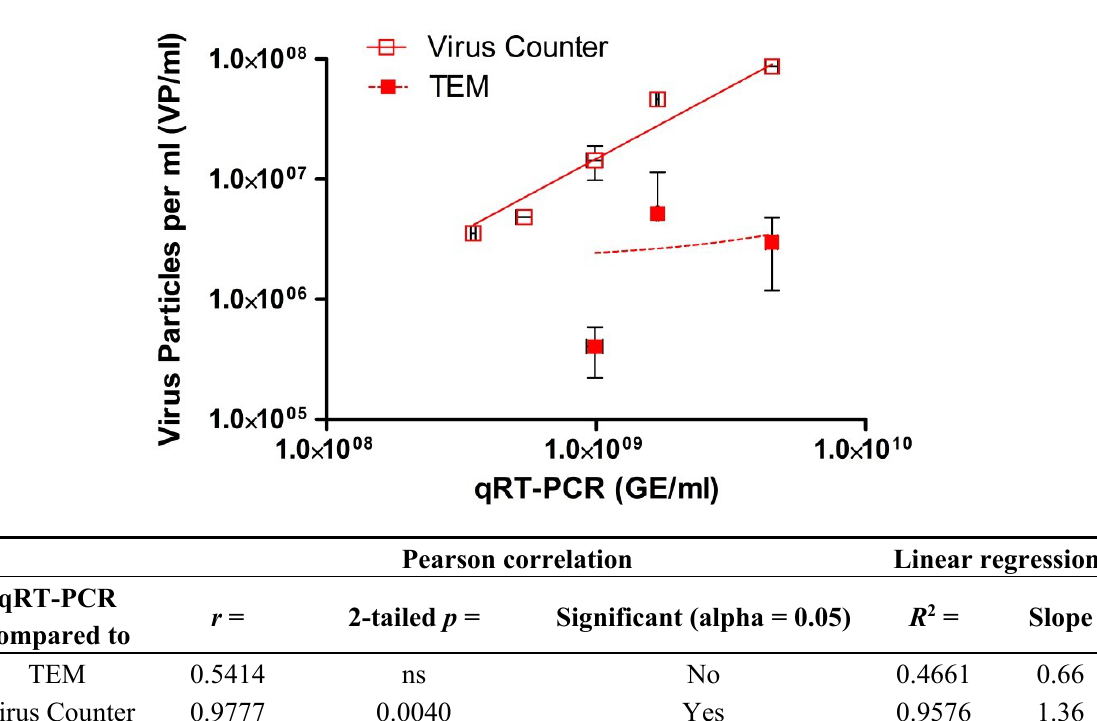
Figure 3. Log-log plot for a dilution series of Ebola virus (EBOV), Kikwit variant, stock virus. Infectious virus was quantified for each sample using six well plates of confluent Vero E-6 cells and an agarose-based plaque assay (PFU/mL) (six replicates) and compared to nucleic acid concentration and particle counts. Nucleic acid concentration, reported as genomic equivalents per mL, was determined using an EBOV-specific qRT-PCR (three replicates). Virus particle counts per mL were measured using the ViroCyt ® Virus Counter 2100 instrument and transmission electron microscopy (TEM) (three replicates each). Bars represent standard deviation.